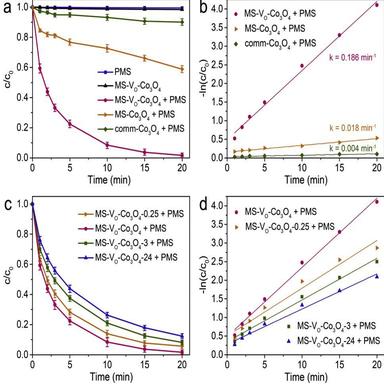
(a) Catalytic degradation of 4-CP over different catalytic systems and (b) the corresponding first-order kinetic analysis results. (c) Catalytic degradation of 4- CP over the MS-VO-Co3O4-x (x = 0.25, 3, 24) catalysts with varied VO content and (d) the corresponding first-order kinetic analysis results. Reaction conditions: = 50 mg/L, = 200 mg/L, catalyst = 50 mg/L.